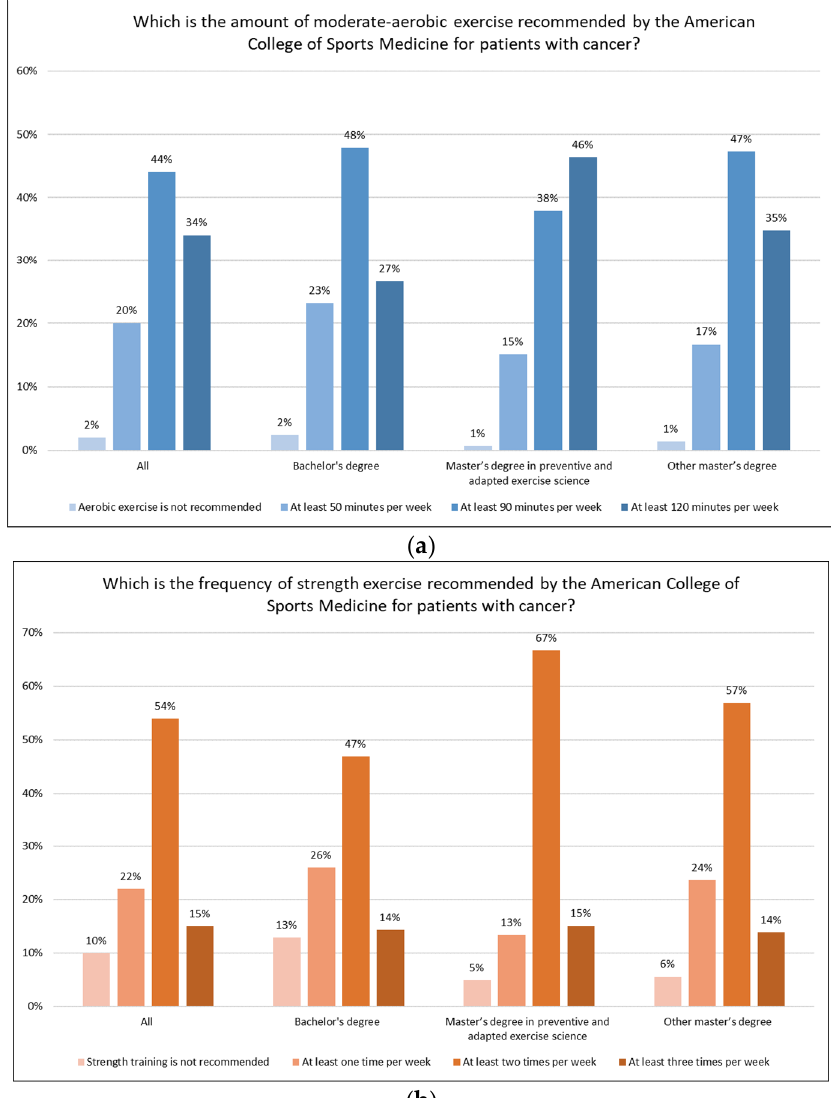
Figure 1. Knowledge of the American College of Sports Medicine’s guidelines for patients with cancer. ( a ) Knowledge of aerobic exercise guidelines; ( b ) knowledge of strength exercise guidelines.